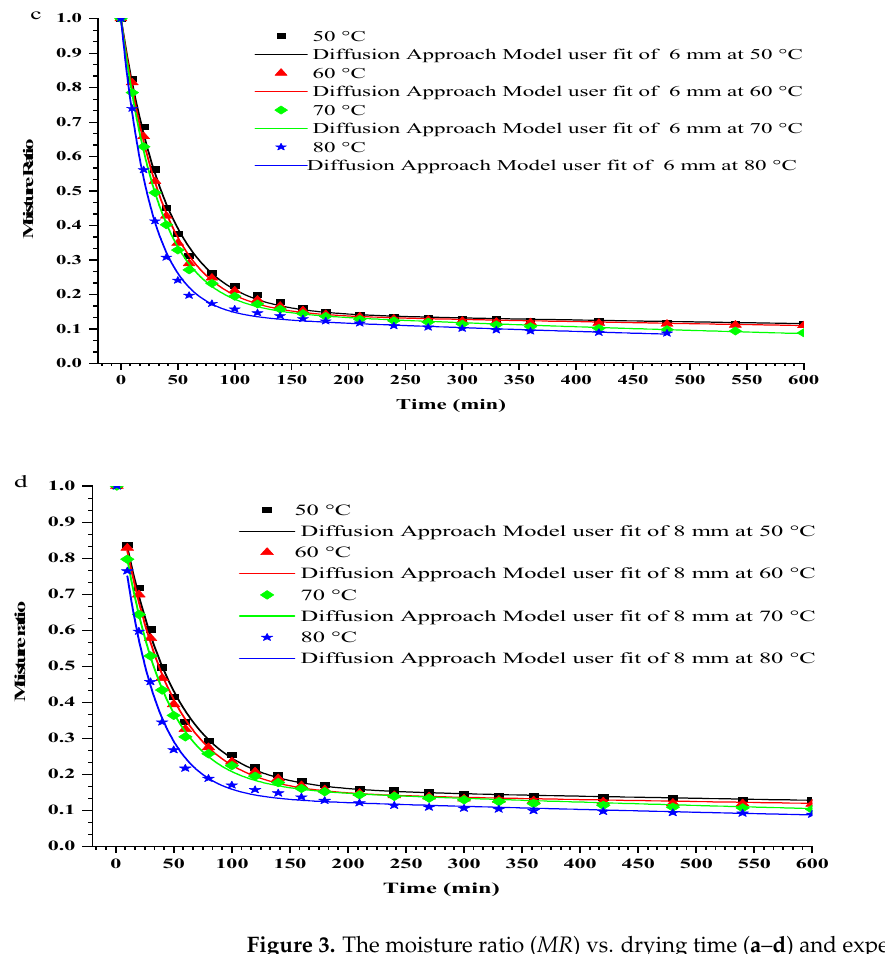
Figure 3. The moisture ratio ( MR ) vs. drying time ( a – d ) and experimental moisture ratio ( MR ) vs. predicted moisture ratio ( MR ) ( e – h ) for plantain banana slices at different drying temperatures and thickness by diffusion approach.